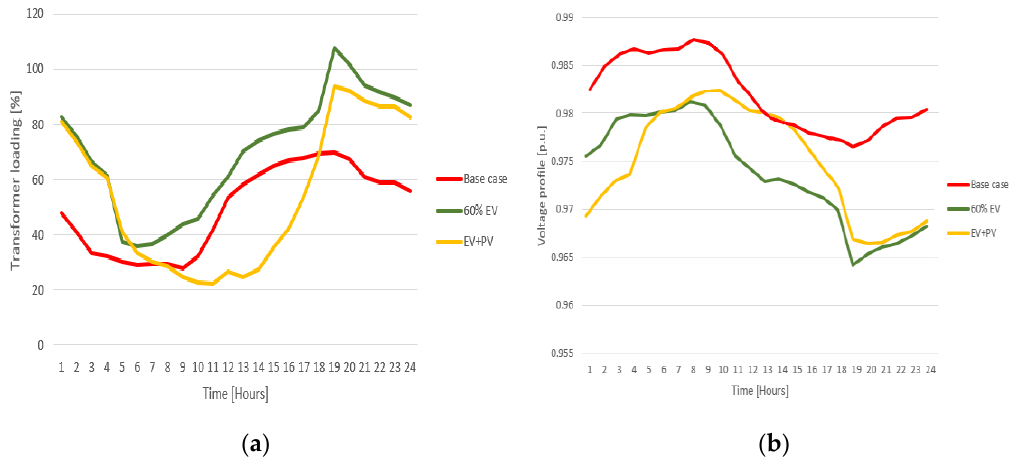
Figure 15. Comparison of rural ( a ) transformer loadings and ( b ) most loaded feeder voltage profiles